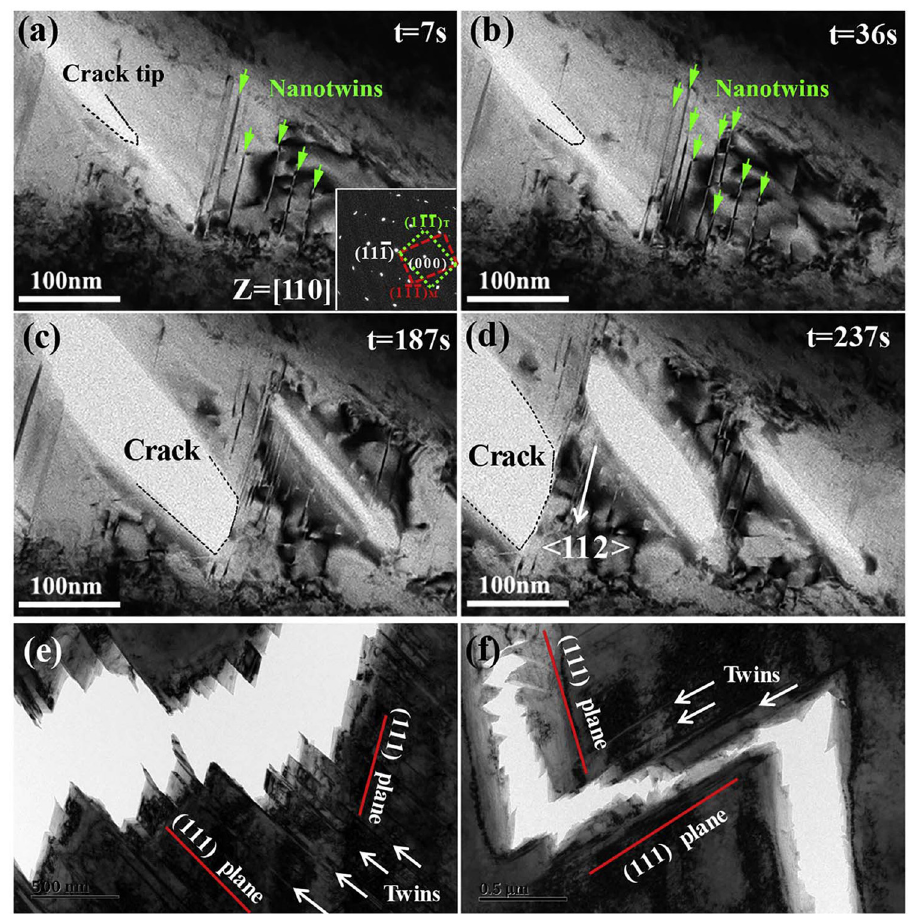
Figure 12: In situ TEM images of the area around a crack tip of the Cr 26 Mn 20 Fe 20 Co 20 Ni 14 during the tensile test, ( a and b ) at the initial steps, nano - twins were visible, ( c and d ) as the tensile process continues, bridging de fl ection and blunting occurred, ( e and f ) at the post - deformation, a crack appeared jagged [ 126 ]